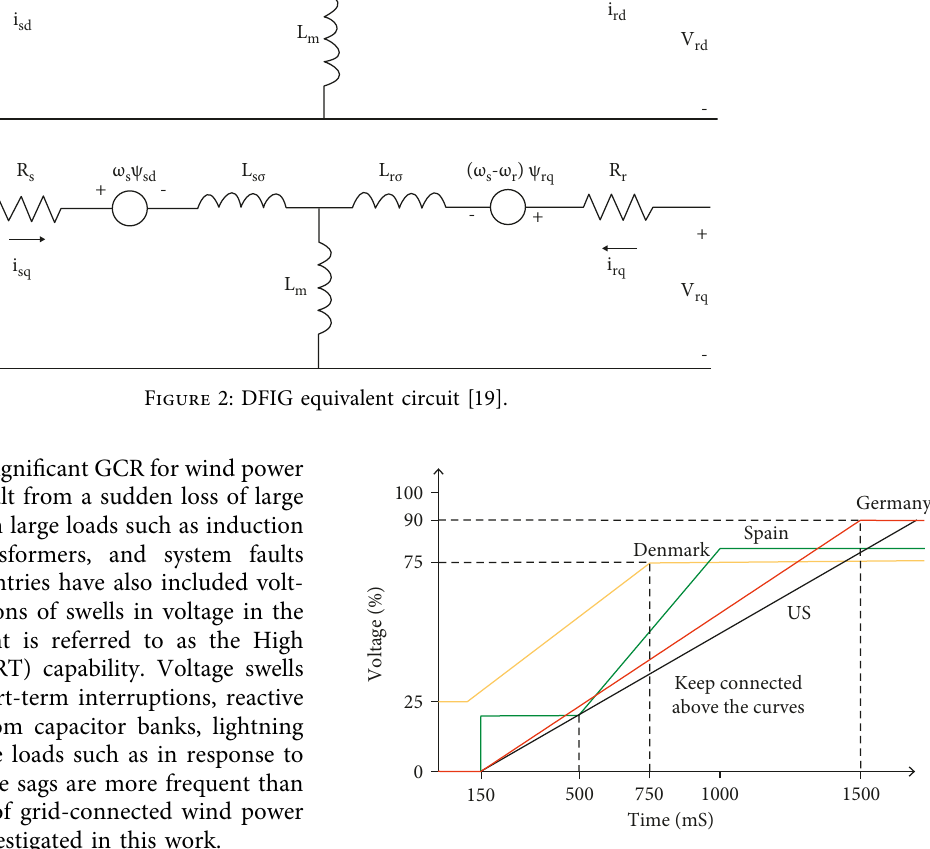
Figure 3: LVRTcapability requirements for various countries